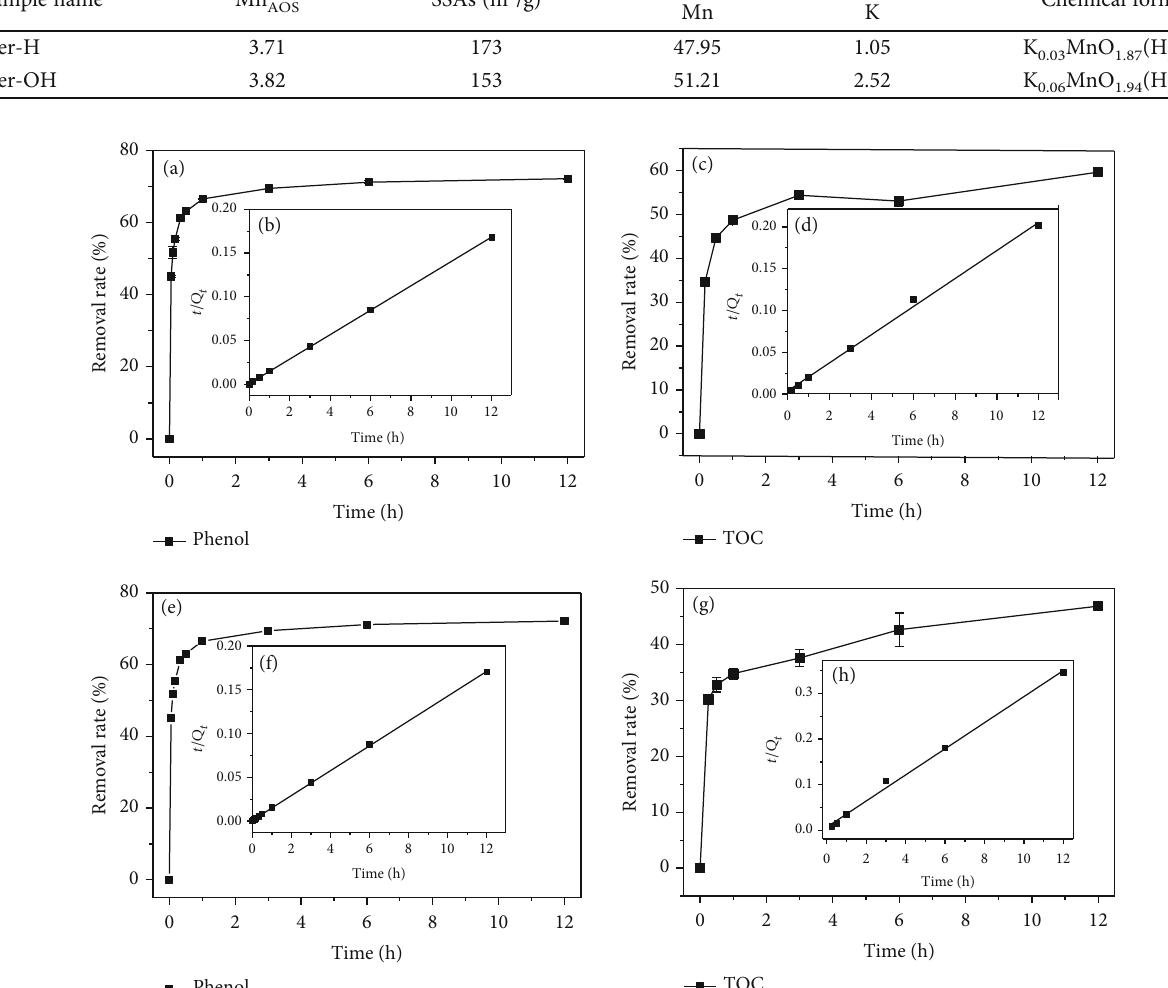
Figure 5: Degradation rates of phenol and TOC (Ver-H (a, c) and Ver-OH (e, g)) and pseudo-second-order kinetic fi tting spectra (Ver-H (b, d) and Ver-OH (f, h)).